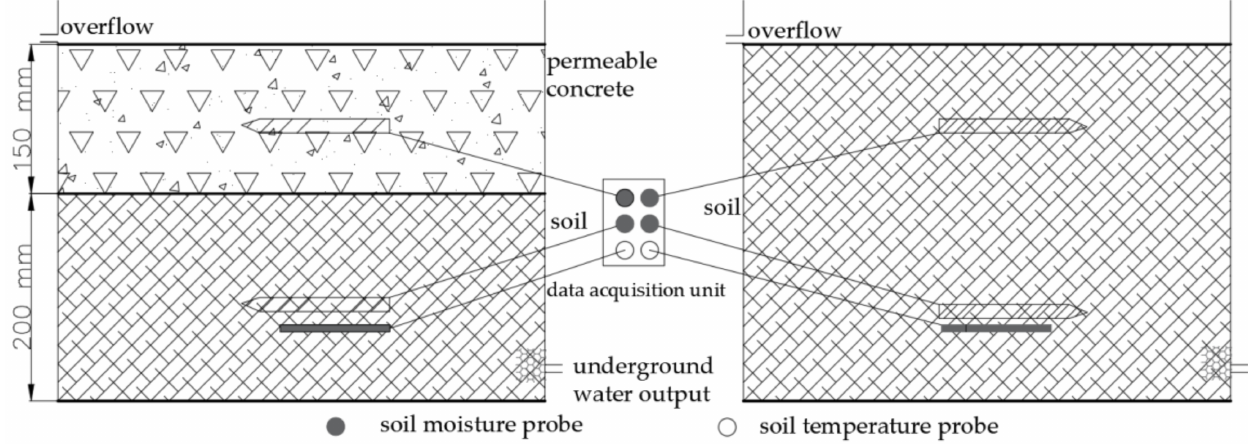
Figure 1. Experimental monitor plan for permeable concrete pavement.